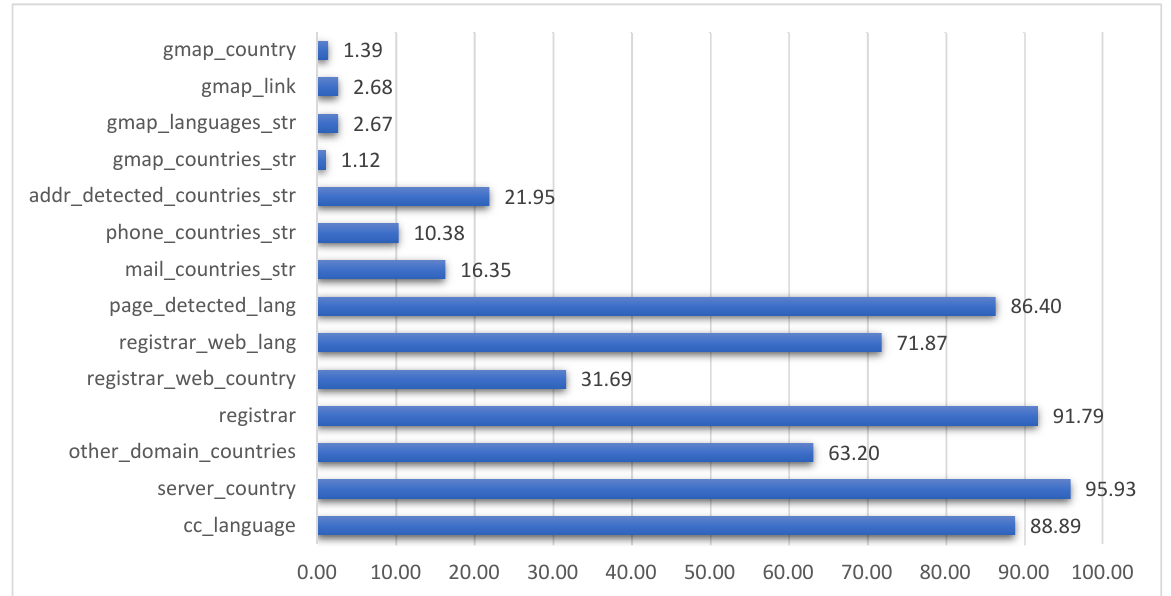
Figure 5. Chart of percentage of variables’ appearances by successfully crawled